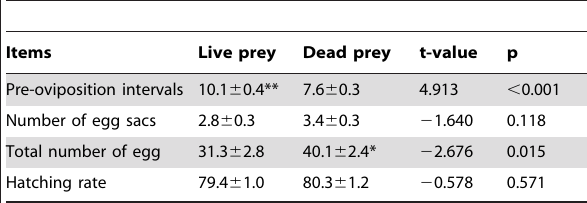
Table 4. The average fecundity ( 6 SE) of Hylyphantes graminicola reared with dead